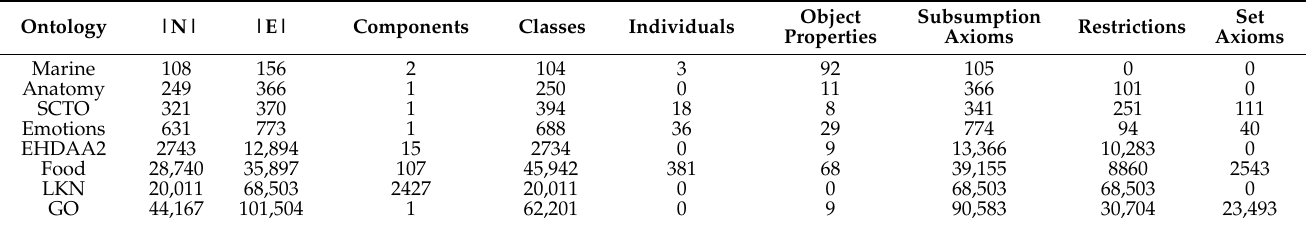
Table 2. Basic statistics of the tested ontologies. Columns |N|, |E|, and Components describe the converted graphs. The rest describes the raw OWL